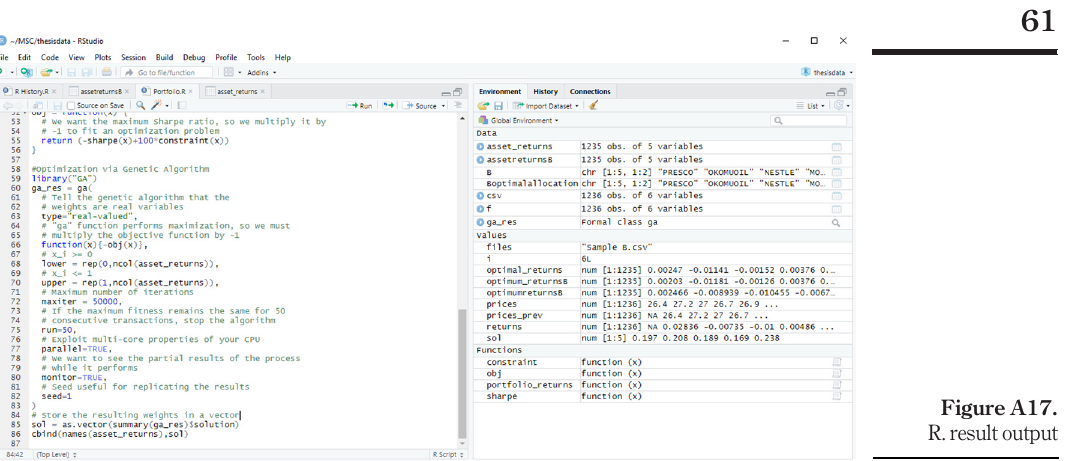
Figure A17. R. result